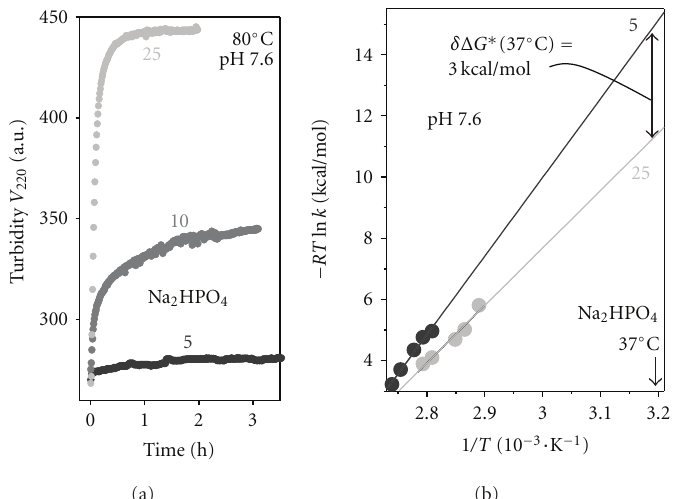
Figure 6: Kinetic analysis of the e ff ects of Na phosphate on VLDL stability. Thermal denaturation of VLDL (0.1mg/mL protein, 5–25 mM Na phosphate as indicated, pH 7.6) was triggered in temperature-jumps from 25 ◦ C to larger constant values of 70–95 ◦ C. The time course of denaturation was monitored by turbidity at 220nm, V 220 ( t ). (a) Representative data recorded in T -jumps to 85 ◦ C; Na phosphate concentrations are indicated. (b) Arrhenius analysis of the T -jump data recorded in 5mM or in 25mM Na phosphate. Solid lines show data fitting by linear functions; the slopes of these functions correspond to the activation energy (enthalpy) E a of VLDL denaturation. Linear extrapolation of the Arrhenius plots to 37 ◦ C suggests that VLDL stability decreases by about 3 kcal/mol upon increasing Na phosphate concentration from 5 to 25mM (double